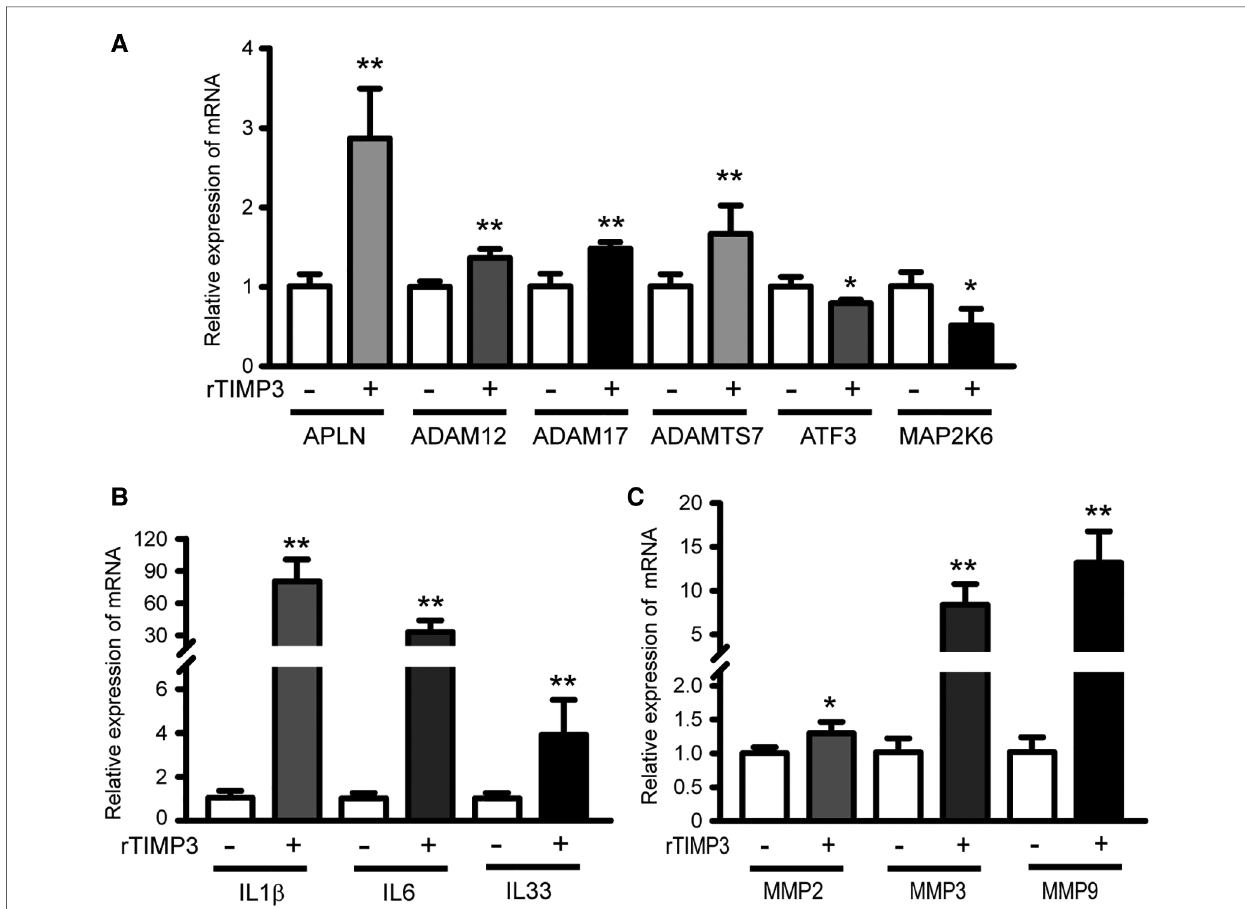
FIGURE 2 Some DEGs regulated by rTIMP3 were veri fi ed by real-time PCR. Neonatal rat ventricular myocytes were treated with rTIMP3 (100 ng/ml) and mRNA levels ( n =3), were determined with real-time PCR. ADAM, a disintegrin and metalloproteinase; ADAMTS7, ADAM with thrombospondin motifs 7; APLN, apelin; ATF3, activating transcription factor 3; IL, interleukin; MAP2K6, dual speci fi city mitogen-activated protein kinase kinase 6; MMP, matrix metalloproteinase. * p <0.05, ** p <0.01 vs.